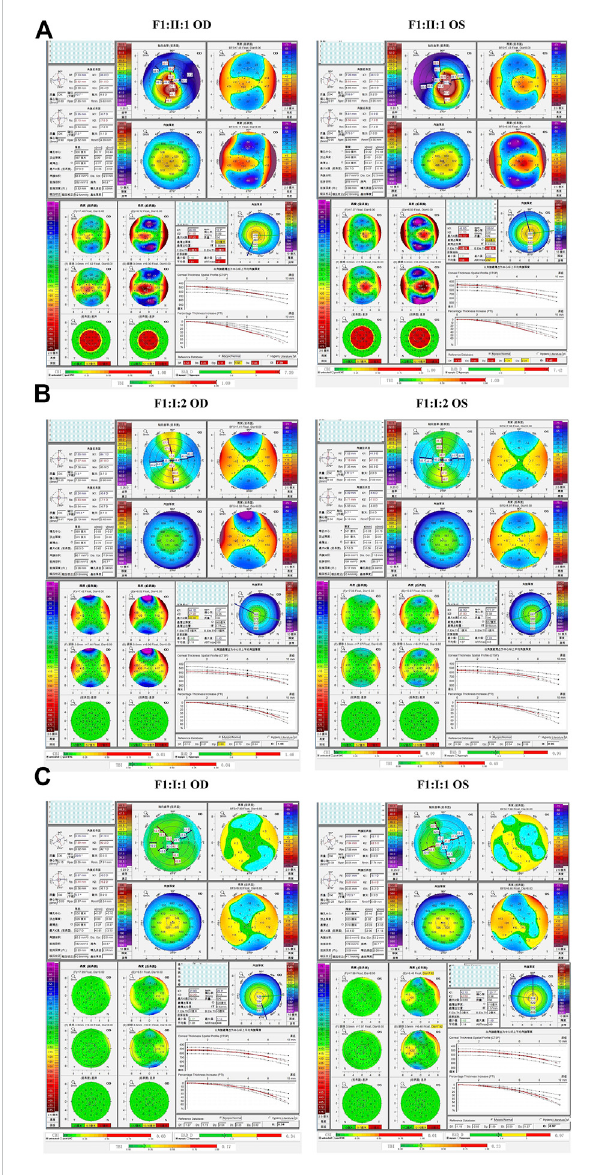
FIGURE 4 Pentacam and Corvis ST images of the proband and fi rst-degree relatives carrying the p.G342E variant in F1. (A) Abnormal maps of the proband. (B) Pentacam examination of the mother with the variant revealed one suspicious parameter (Dp) and one abnormal parameter (Kmax) in the right eye, while one suspicious parameter (TBI) was detected by Corvis ST examination of the left eye. (C) PentacamandCorvisSTexaminationsofthefather(F1:I:1)withoutthe c.1025G > A variant revealed normal parameters. OD: right eye; OS: left